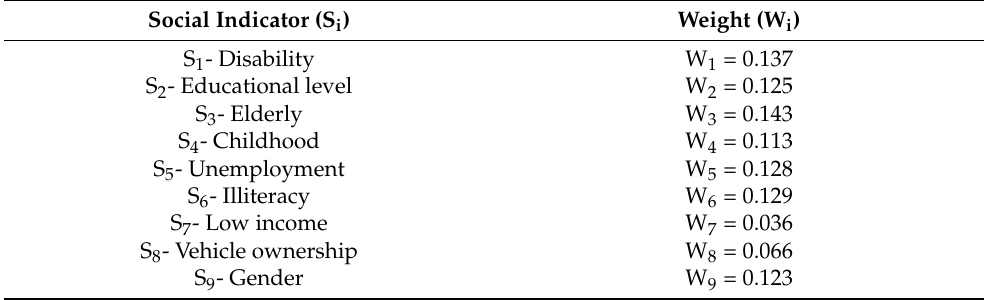
Table 3. Social Indicators